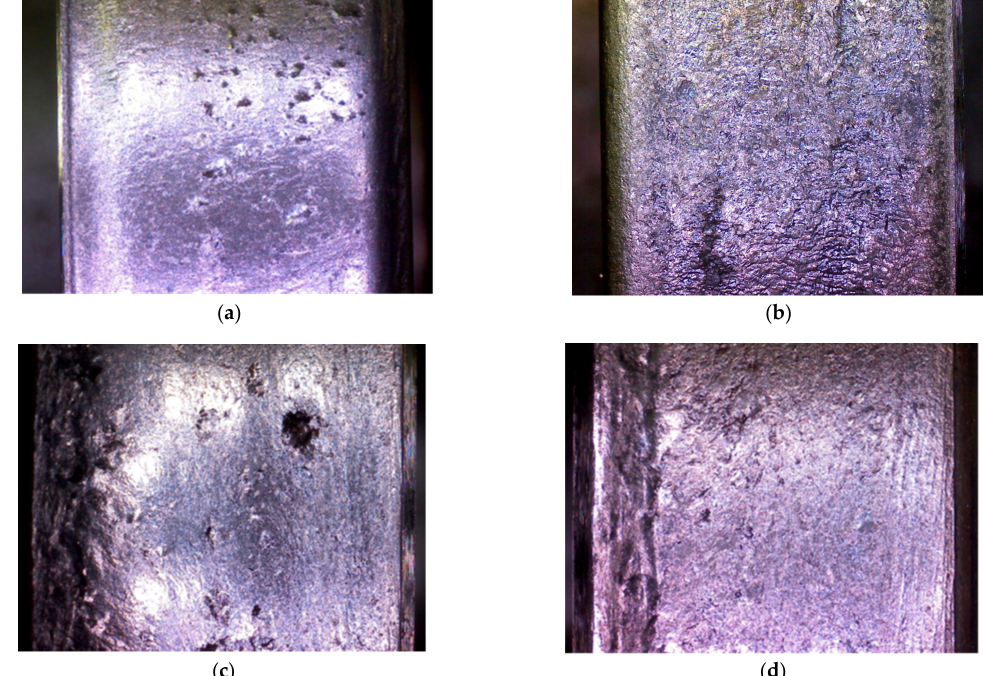
Figure 23. Wheel and rail surface condition after fatigue test: ( a ) Rail: KS 60; ( b ) Wheel: RSW; ( c ) Rail: UIC 60; ( d ) Wheel: R7.